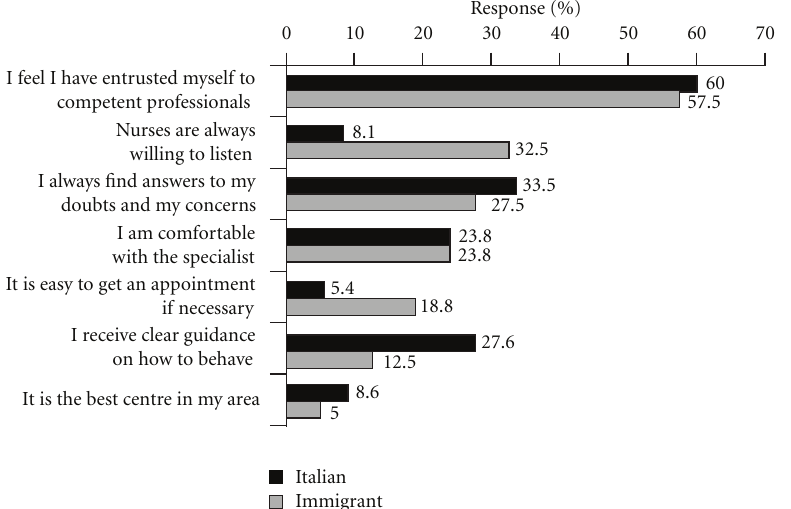
Figure 3: Relationship between patients and diabetes centre. (The sum exceeds 100% because multiple answers were